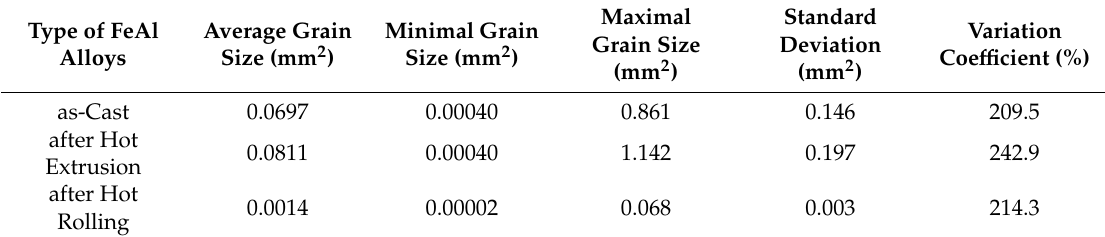
Table 3. Grain parameters of the FeAl alloy.